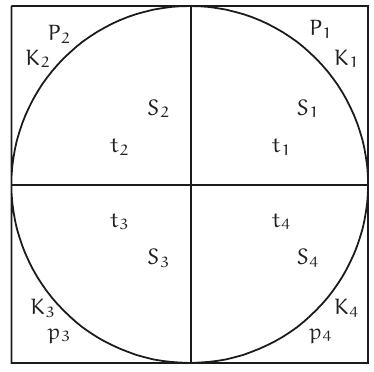
Figure 4.2. The simplest case of triangulation with the new